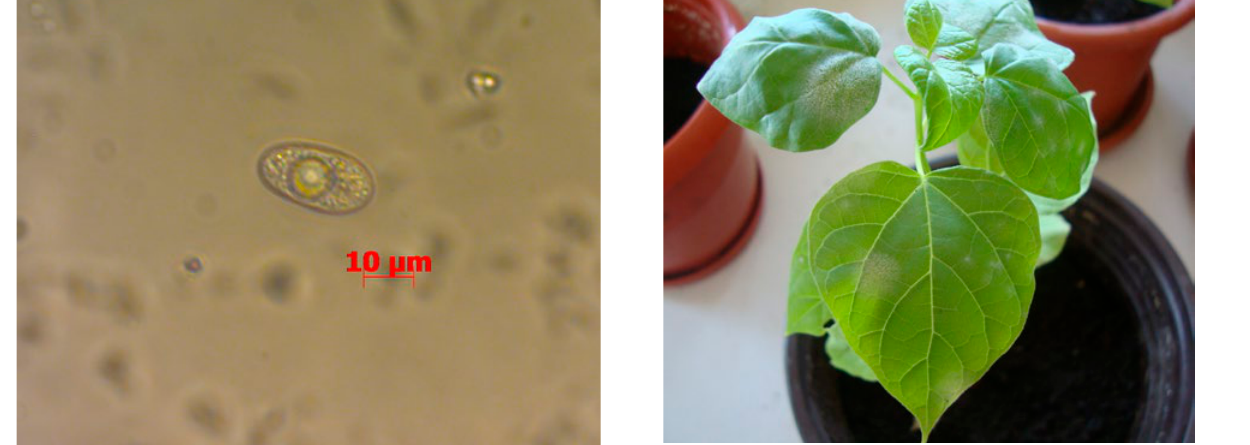
Figure 8. Ascospore of Erysiphe elevata . Figure 9. Powdery mildew colonies developed on inoculated catal- pa leaves.